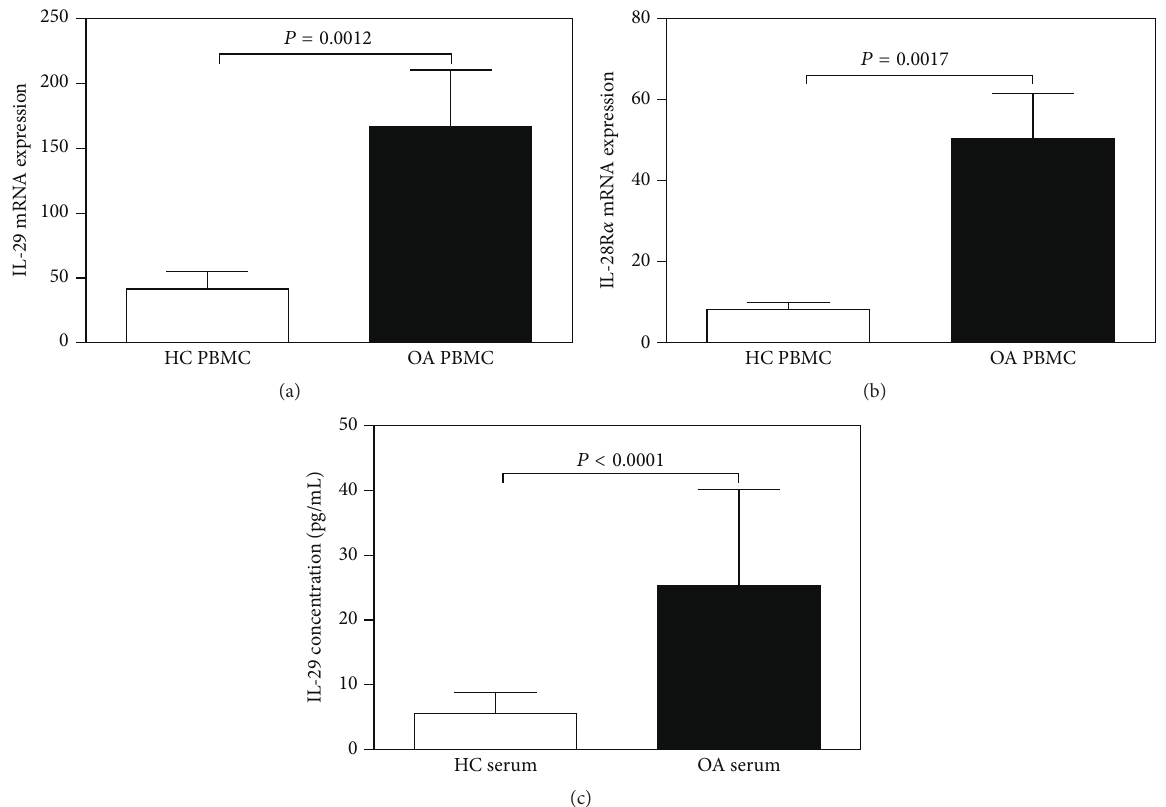
Figure 1: The expression of IL-29 and its receptor IL-28R 𝛼 in the peripheral blood mononuclear cells (PBMCs) and serum of OA patients. The mRNA levels of IL-29 (a) and IL-28R 𝛼 (b) in the OA PBMC ( 𝑛 = 30 ), when compared with that in HC PBMC ( 𝑛 = 30 ), were detected by real-time PCR. (c) The levels of IL-29 in the serum from OA patients ( 𝑛 = 30 ) and HC ( 𝑛 = 30 ) were assessed by ELISA. Data in graphs are the mean ±